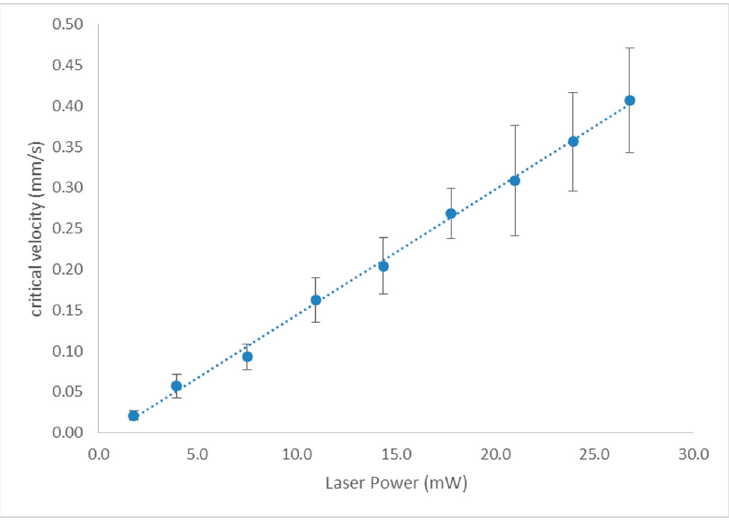
Figure 5. Dependence of critical velocity, v c , on laser power.